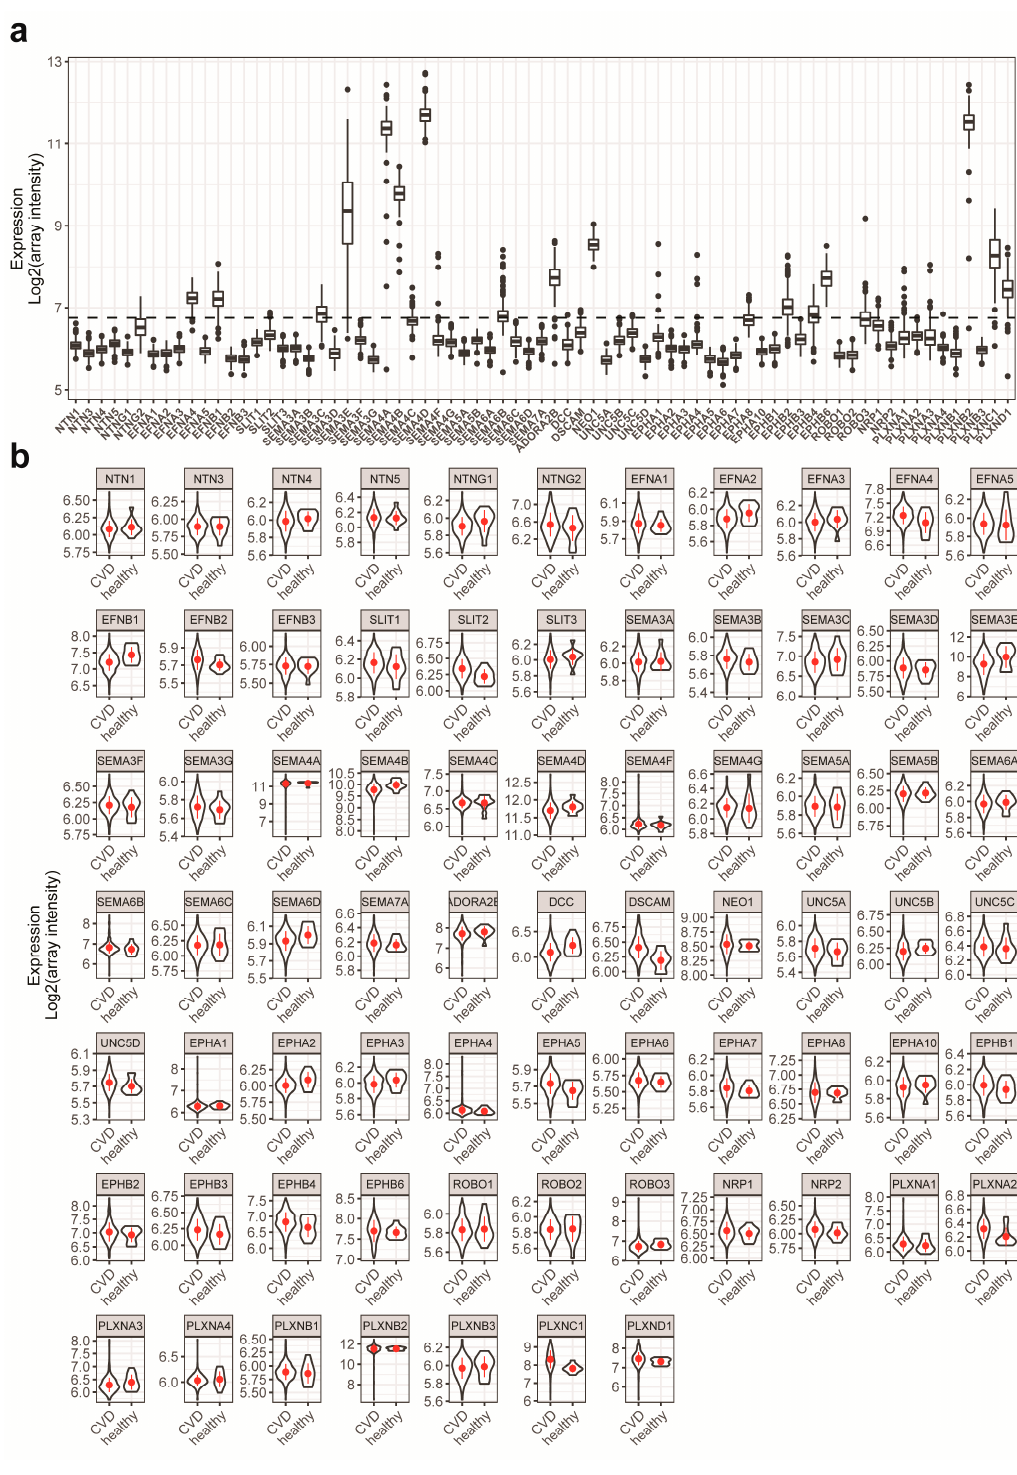
Figure 2. NGC expressions in patients and healthy subjects. ( a ) Box plots with quartiles were created using NGC expressions from all individuals. Baseline signal of the platform (6.75) was indicated with the dashed line. ( b ) Violin plots of all NGC expressions were created for cardiovascular disease (CVD) patients and healthy individuals. The violin shapes represent the density distribution of NGC expressions in the groups. The NGC expressions of CVD patients overlap with those of healthy individuals. Due to the small number of healthy individuals, their NGC expressions were sometimes not normally